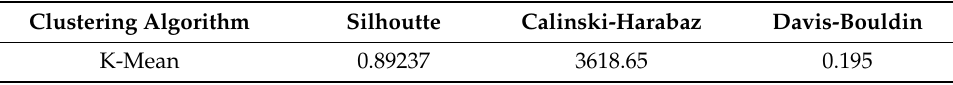
Figure 3. The 3D visualization of user behavior leveraging the K-means algorithm. Table 3. K-means performance metrics.